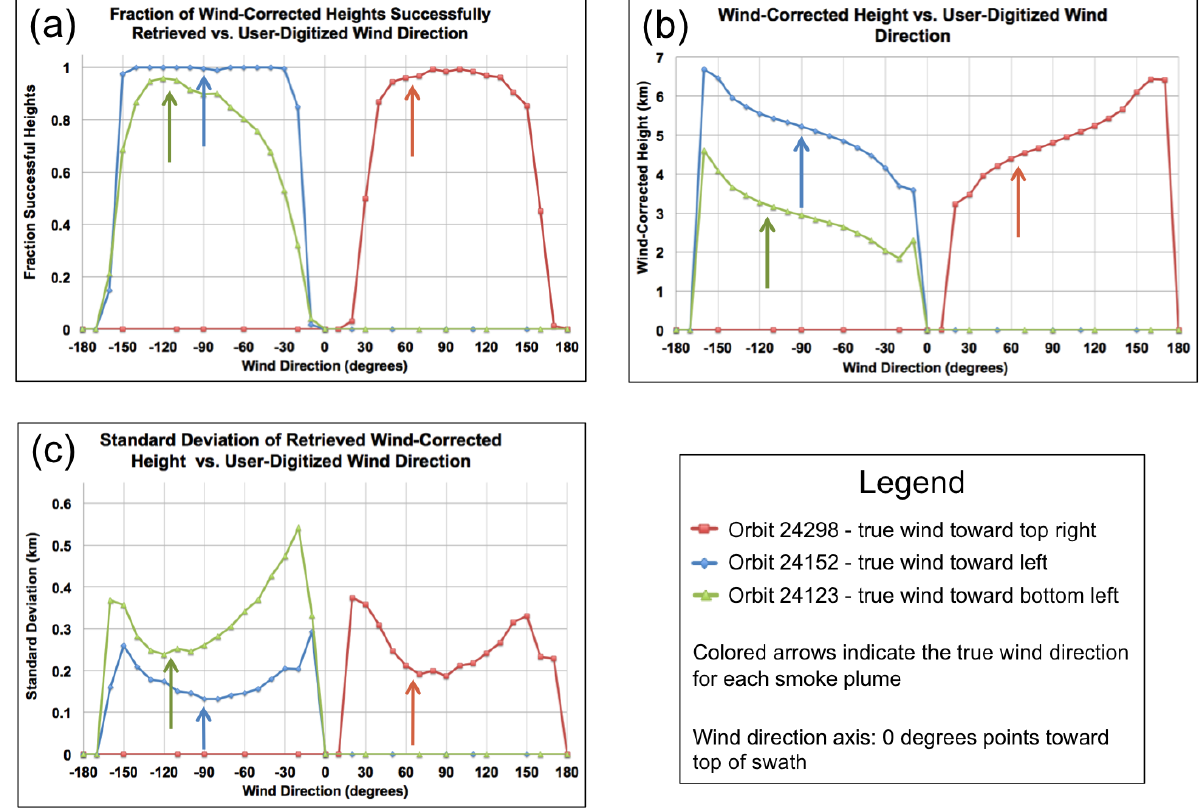
Figure 11. Graphs showing relationships of wind-corrected height retrievals to digitized wind direction for the three plumes in Figure 9: ( a ) The fraction of successful zero-wind retrievals that resulted in successful wind-corrected retrievals; ( b ) wind-corrected height; ( c ) standard deviation of wind-corrected heights. Colors represent different plumes in Figure 9. Vertical arrows indicate the “true” wind direction for each plume. Zero-wind directions are −90 and +90